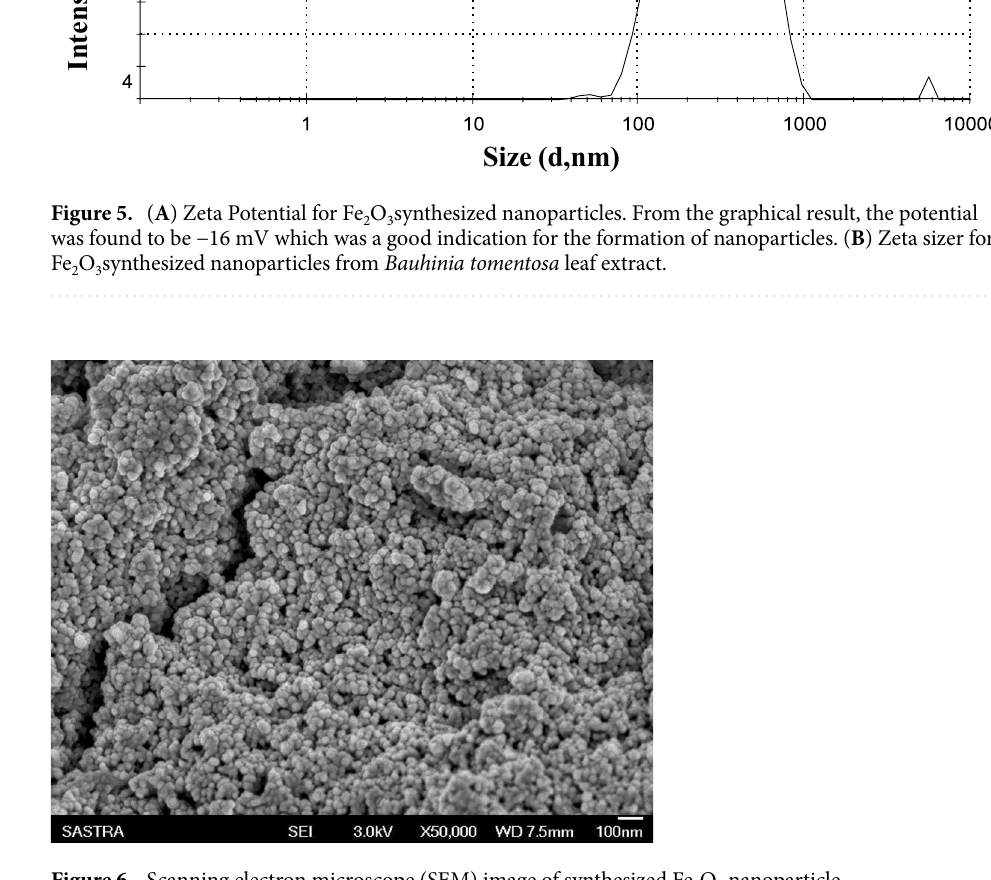
Figure 6. Scanning electron microscope (SEM) image of synthesized Fe 2 O 3